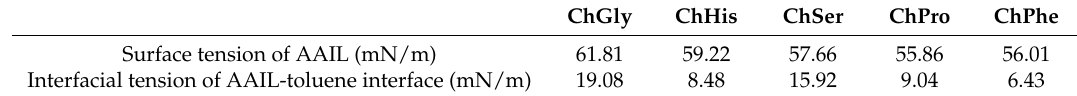
Table 4. Solids entrained in asphalt-toluene solution in different extraction systems. ChGly- ChHis- Toluene